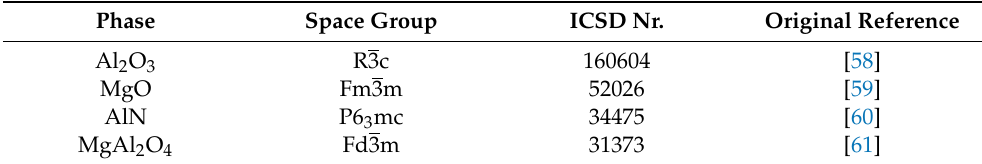
Table 4. Crystal structure data used for the Rietveld refinement of Al 2 O 3 , MgO, AlN, and MgAl 2 O 4 . Phase Space Group ICSD Nr. Original